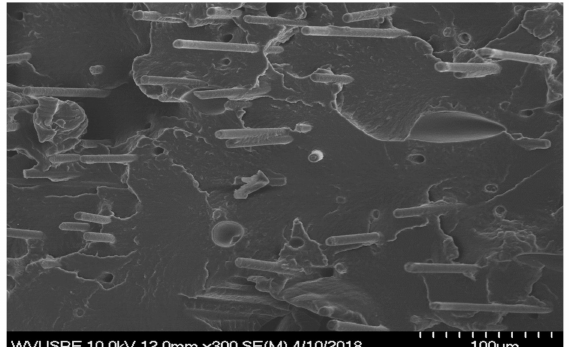
Figure 7. SEM image of CFRP specimen printed at 45 ◦ direction.